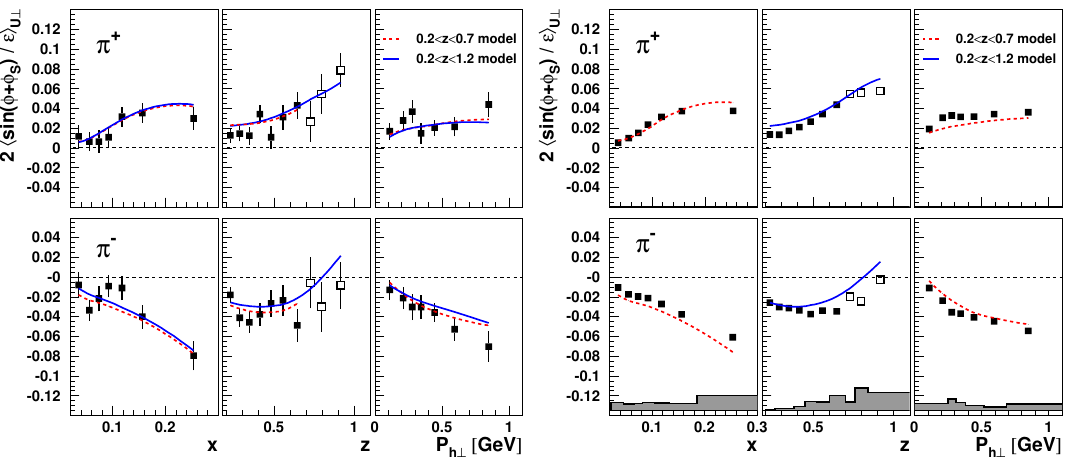
Figure 48 . Left: comparison of the HERMES data for charged-pion Collins SFA amplitudes with the fully differential model of those evaluated at the average kinematics of each bin. The dashed curve (red) uses the model based on data in the standard 0 . 2 < z < 0 . 7 range, while the solid line (blue) includes also the high- z data. Right: comparison of the fully differential models evaluated at the average kinematics of each bin with the fully reconstructed “polarized Pythia6.2 ” simula- tion (in HERMES acceptance) based on those models. The difference is assigned as systematic uncertainty and shown as uncertainty bands at the bottom of each